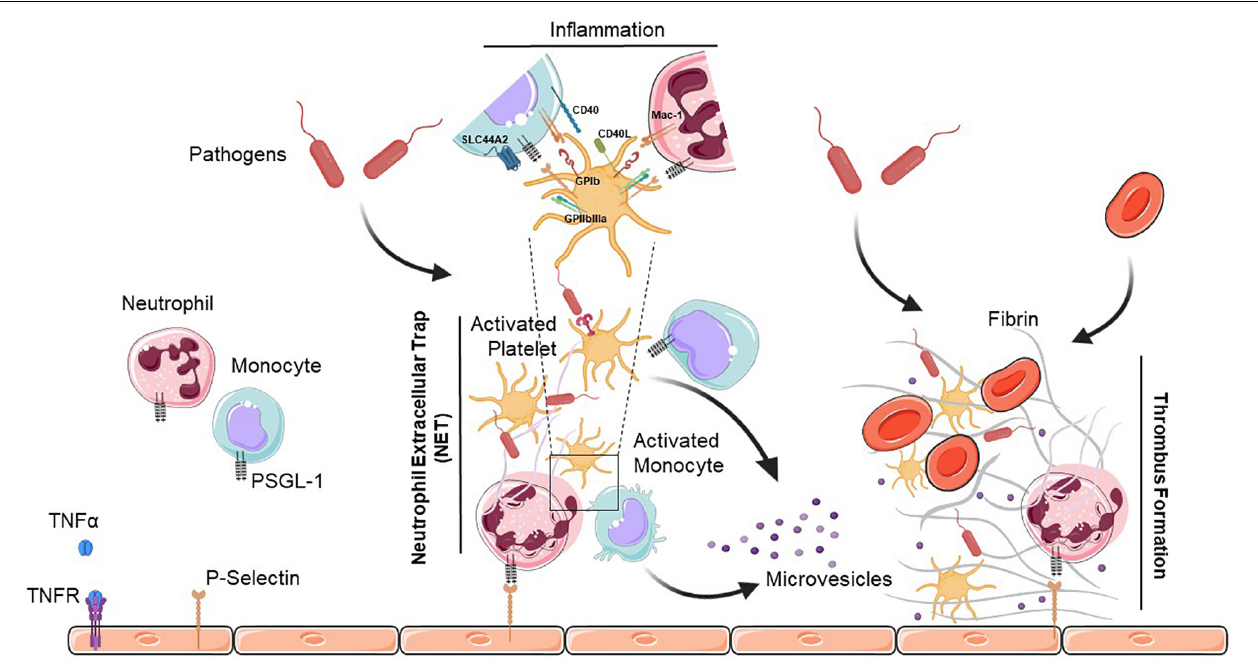
FIGURE 1 | Neutrophil extracellular trap (NET)-mediated platelet thrombosis. In the presence of pathogens, TNF α binds to its receptor (TNFR) to initiate diverse cellular responses, and platelets, neutrophils and monocytes collaborate to form NETs that are highly thrombotic and resistant to tissue plasminogen activator-mediated fibrinolysis. NETs also help to recruit platelets which support the immuno-thrombotic process by promoting fibrin generation along with endothelial cells. Activated platelets release large amounts of pro-inflammatory cytokines in platelet extracellular vesicles. Interactions between platelets and neutrophils or monocytes occur via direct contact between cell surface receptors, or by binding of secreted ligands. PSGL-1, P-selectin glycoprotein ligand-1; TNF α , tumor necrosis factor alpha; TNFR, tumor necrosis factor receptor; GPIb, glycoprotein Ib; SLC44A2, solute carrier family 44 member 2; CD40L, cluster of differentiation 40 lignad; CD40, cluster of differentiation 40; Mac-1, macrophage-1 antigen; GPIIbIIIa, glycoprotein